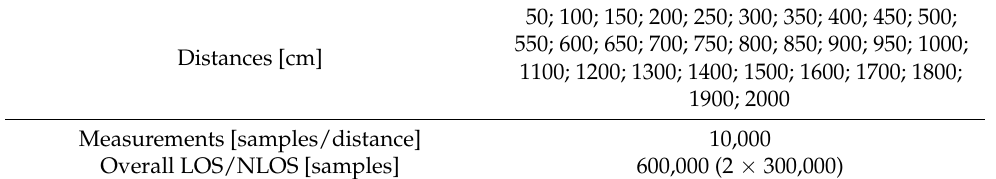
Table 1. Reference distances.